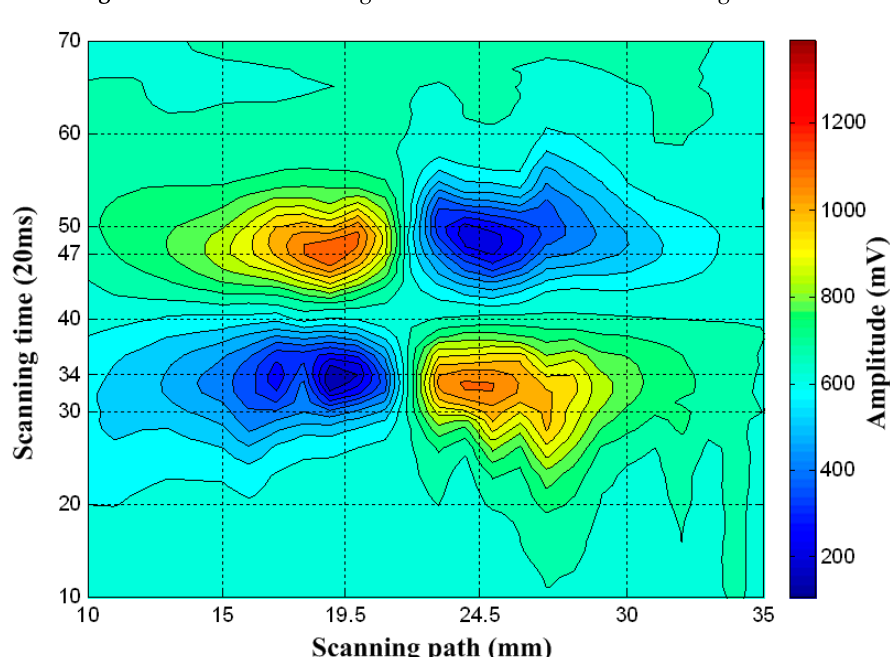
Figure 9. C-scan outline images of defect 2 in the direction of magnetic flux. Applied Science. 2018 , 9 , x FORPEERREVIEW